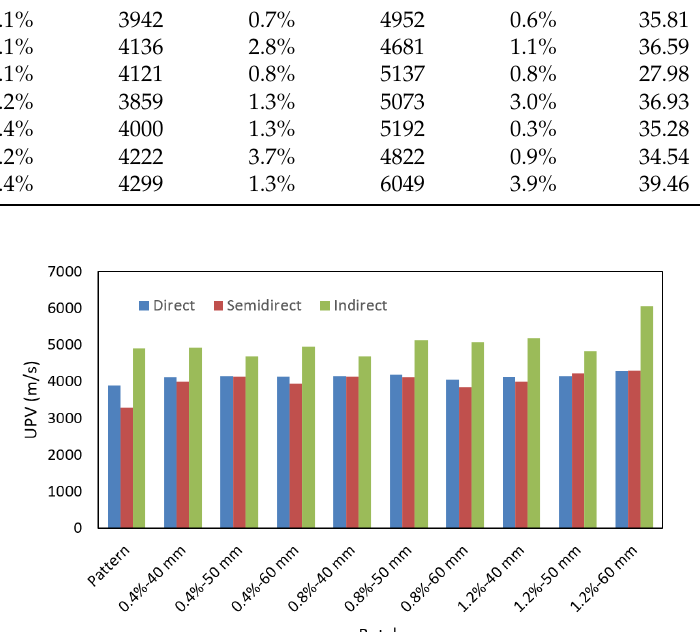
Figure 6. UPV results for concrete mixtures.